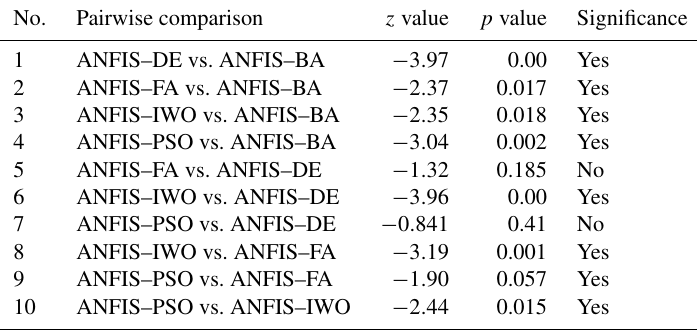
Table 4. Results of the Wilcoxon signed-rank test.